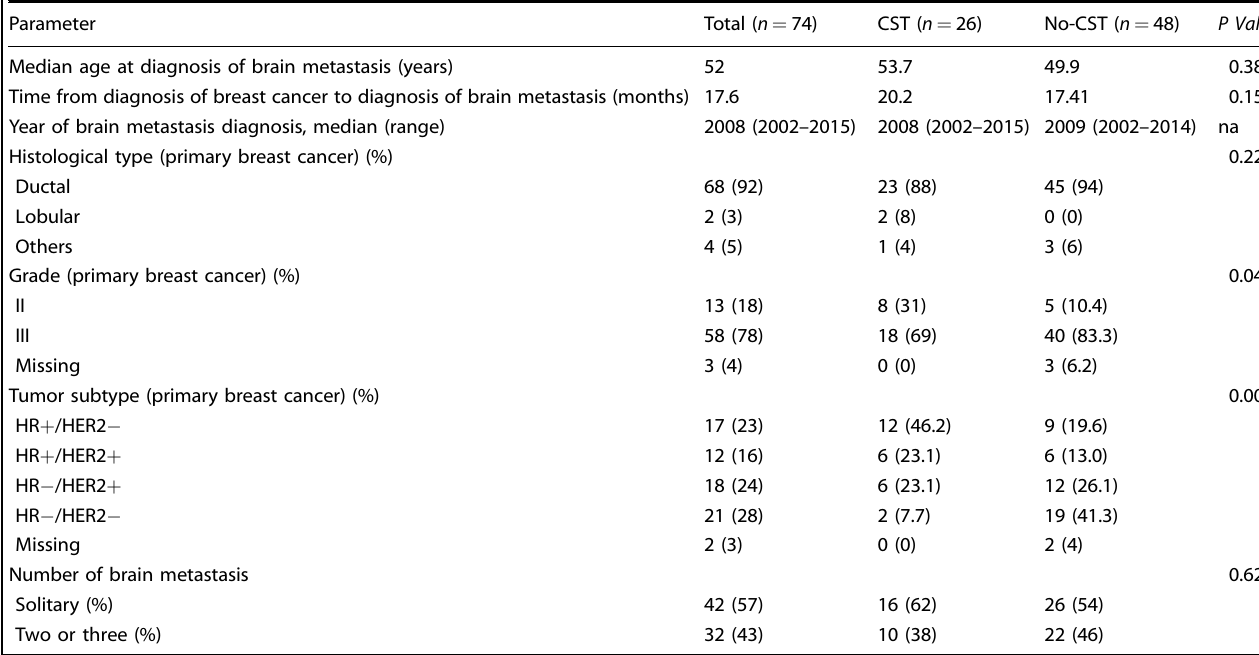
Table 1. Baseline characteristics of analyzed patients.